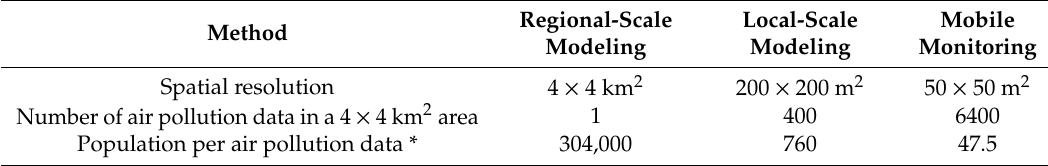
Table 1. Comparison of spatial resolutions for three modeling / monitoring